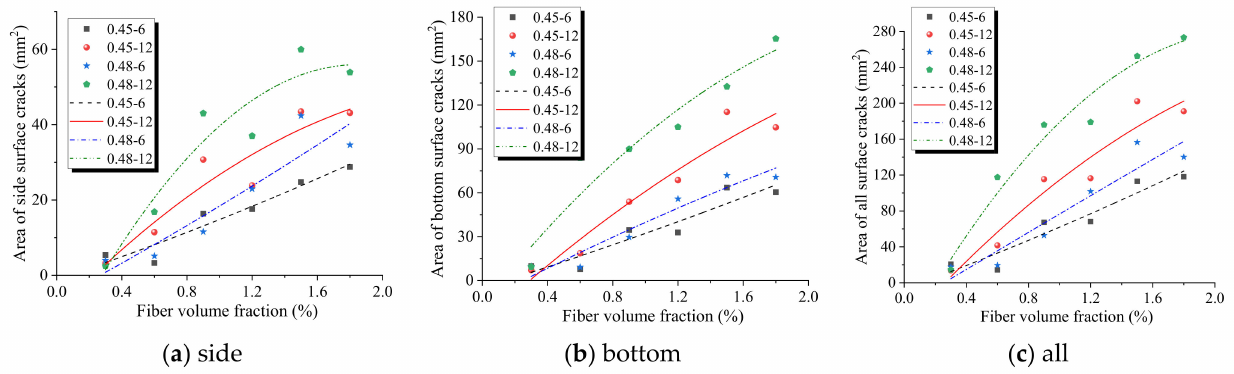
Figure 6. Relationship between fiber volume fraction and crack